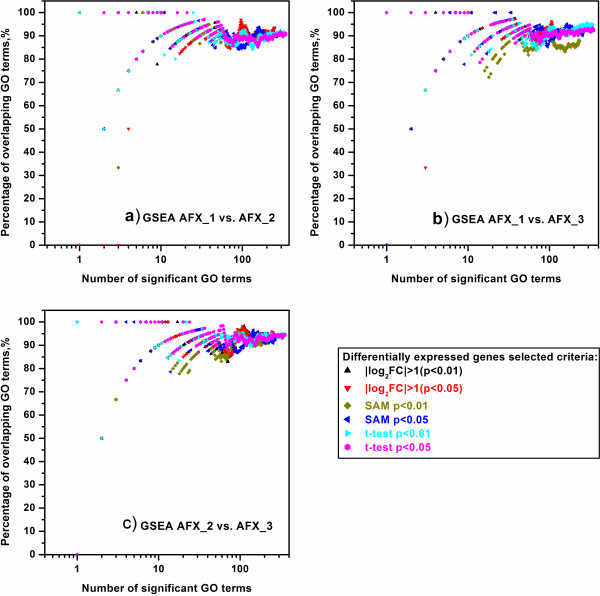
Intra-platform concordance of significant GO terms enriched by GSEA among three test sites of AFX. (a) AFX_1 versus AFX_2; (b) AFX_1 versus AFX_3; (c) AFX_2 versus AFX_3. The scatter plots showed the percentage of overlapping GO terms which were enriched by GSEA and derived from two test sites. Each color and each type of points represented the different gene lists that selected by different statistical methods and different cutoff. The x-axis represents the number of enriched GO terms selected as significance, and y-axis is the percentage (%) of GO terms common to the two AFX test sites enrichment results. The _1, _2 and _3 suffixes refer to test site locations.